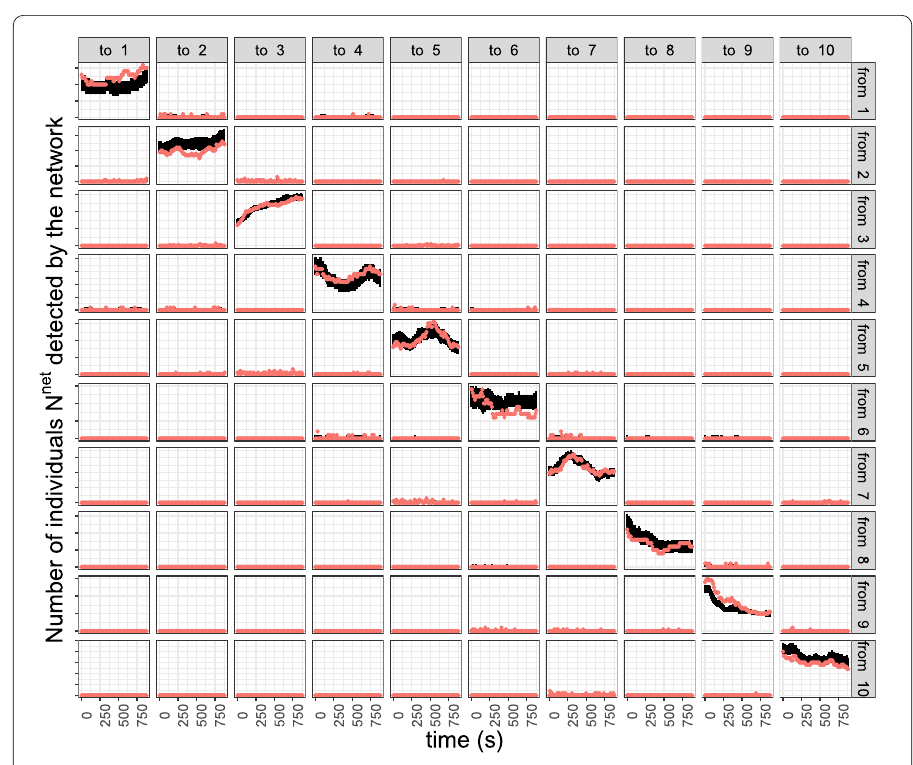
Figure 13 Credible intervals for the OD matrix of the number of individuals N net t per region. Credible intervals (prob = 95%) for the OD matrix of number of individuals ¯ N net t per region detected by the network compared to true values (in red) computed according to the distribution in eq. (19) using the RSS geolocation model with uniform